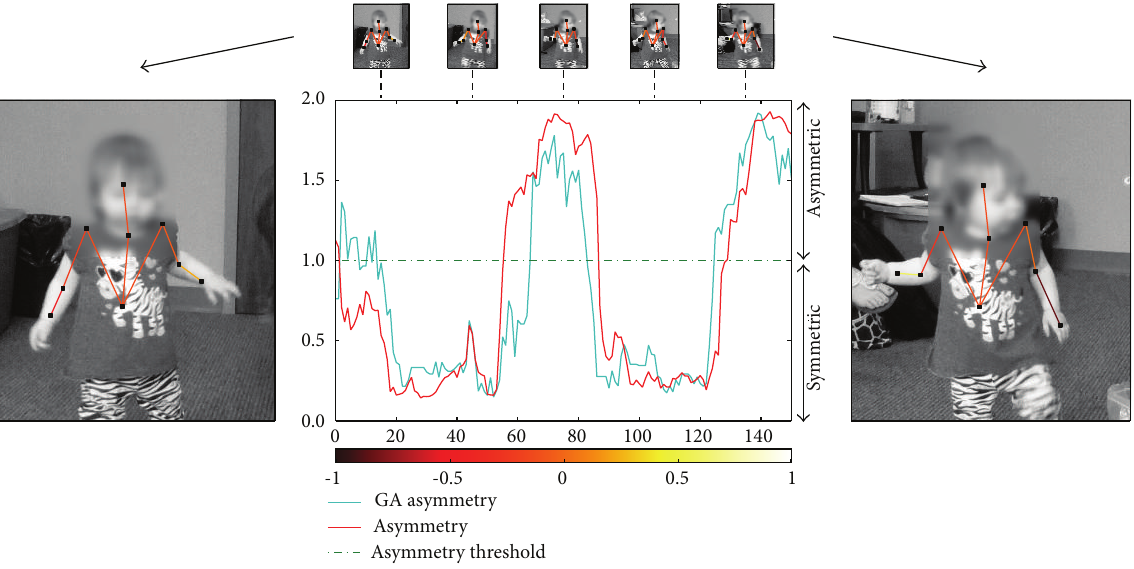
Figure 5: Comparison of arm-asymmetry scores between automatic method and ground truth in a video segment containing participant number 1. The cyan line represents normalized results from our method, while the red line represents the ground truth (GT) of the normalized arm differences. See [28] for more information on arm-asymmetry calculations and analysis. The normalized color scale visually displays the angle difference between the right and left forearms, where symmetric arm positions have similar overlaying